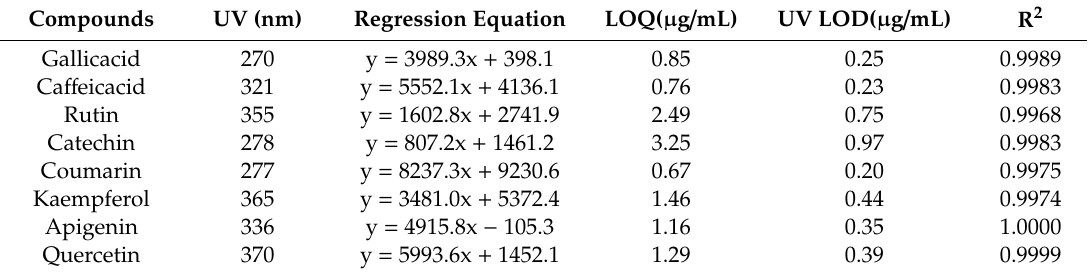
LOD: Limit of detection, LOQ: Limit of